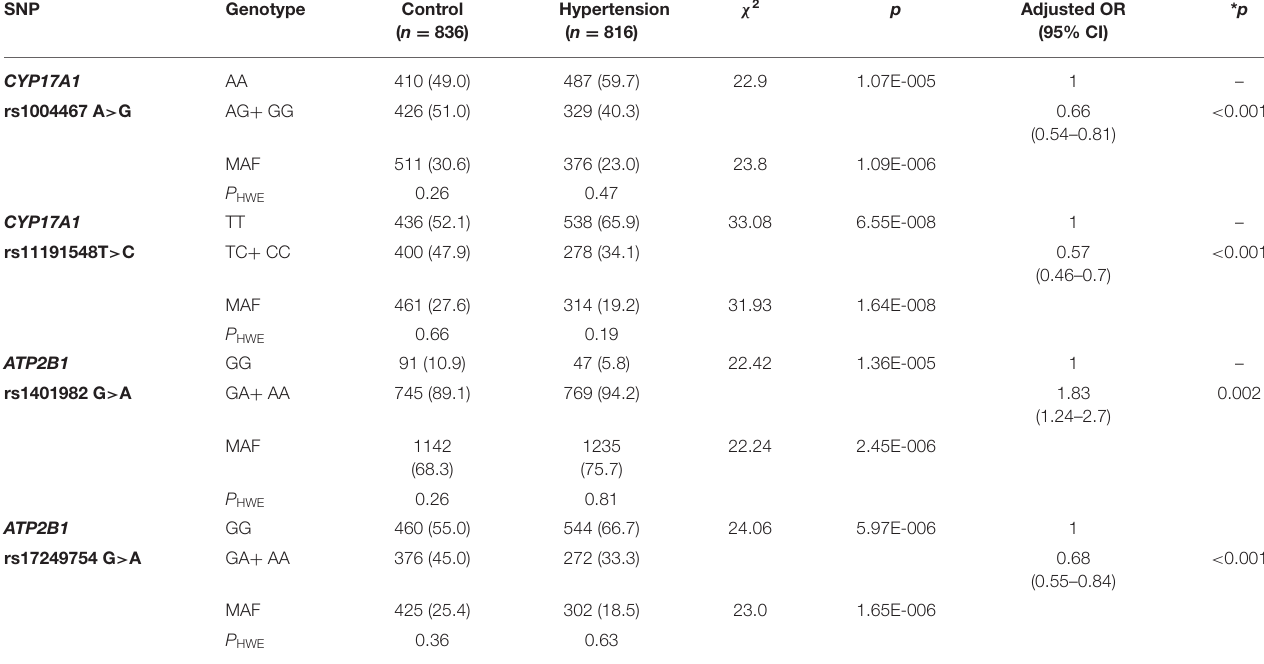
TABLE 2 | Correlation between the CYP17A1 – ATP2B1 polymorphisms and hypertension.